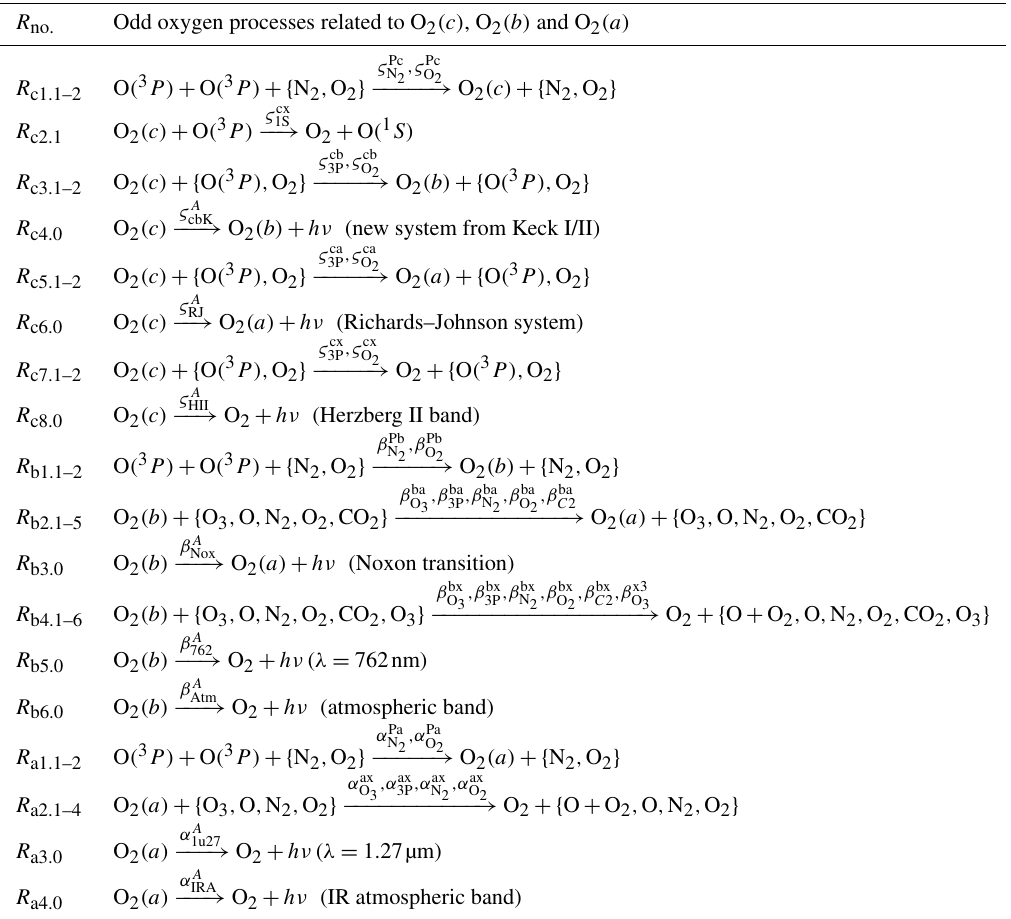
Table 6. The processes shown here comprise the MAC model together with the processes shown in Table 5 and the processes shown in Table